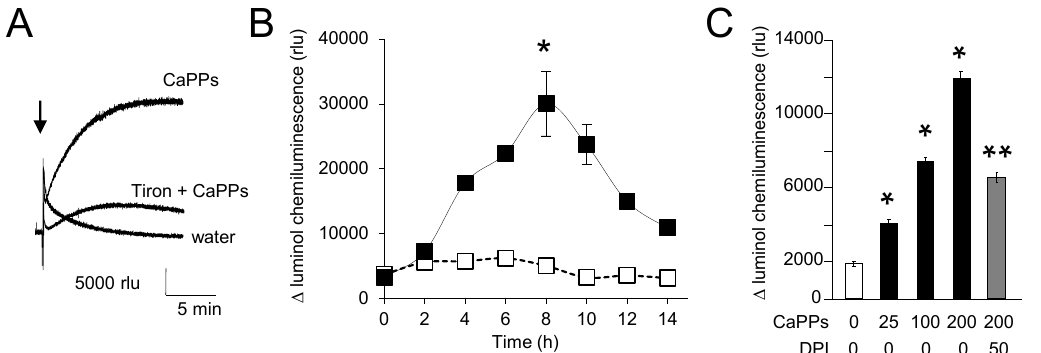
Figure 3. Biological CaPP-induced ROS generation by BY-2 cells. ( A ). Typical time CLA luminescence recorded with BY-2 cells after addition of 100 µ g.mL − 1 CaPPs with or without 20 mM tiron. ( B ).